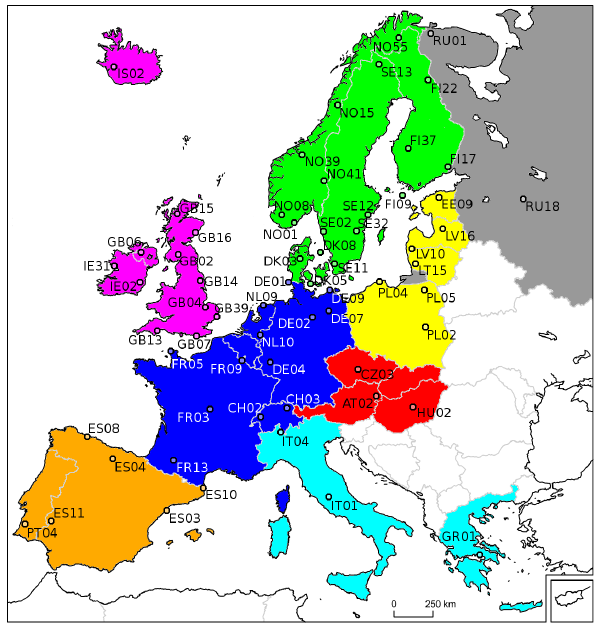
Fig. 12. Map indicating the location of EMEP measurement stations used for comparison with simulated air concentrations (Table 4). The coloured areas are geographical regions used for regional analysis in Fig. 15. Yellow: Estonia (EE), Lithuania (LT), Latvia (LV), Poland (PL). Orange: Spain (ES), Portugal (PT). Red: Austria (AT), Czech Republic (CZ), Hungary (HU), Slovakia (SK). Pink: Ireland (IE), Iceland (IS), Great Britain (GB). Turquoise: Italy (IT), Greece (GR). Green: Denmark (DK), Finland (FI), Norway (NO), Sweden (SE). Blue: Belgium (BE), Switzerland (CH), Germany (DE), France (FR), Luxembourg (LU), Netherlands (NL). Grey: Russia